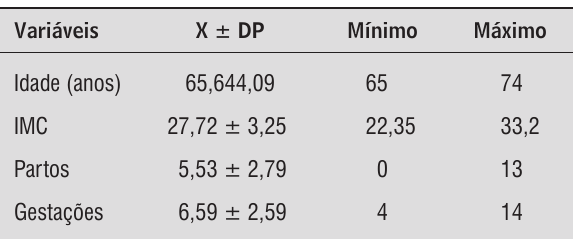
Tabela 1 - Médias e desvios-padrão das características Tabela 2 - Médias e desvios-padrão da avaliação descritivas das 22 mulheres com queixa clínica